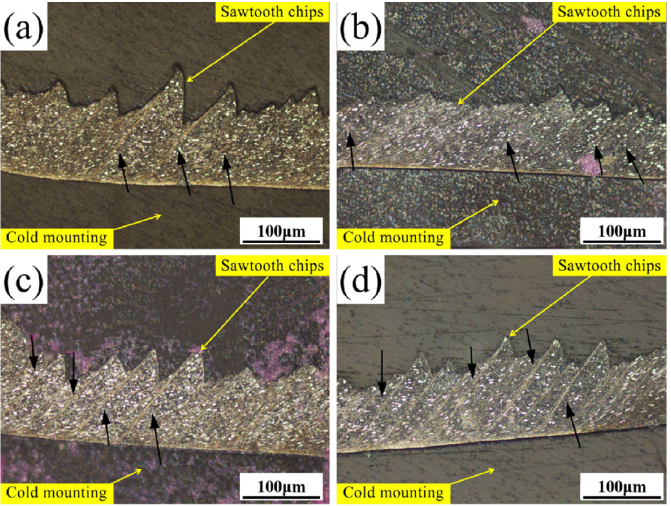
Figure 12. Cross-section microstructure of the chip using UCI: ( a ) CT; ( b ) 0.42 A/mm 2 ; ( c ) 0.57 A/mm 2 ; and ( d ) 0.90 A/mm 2 .